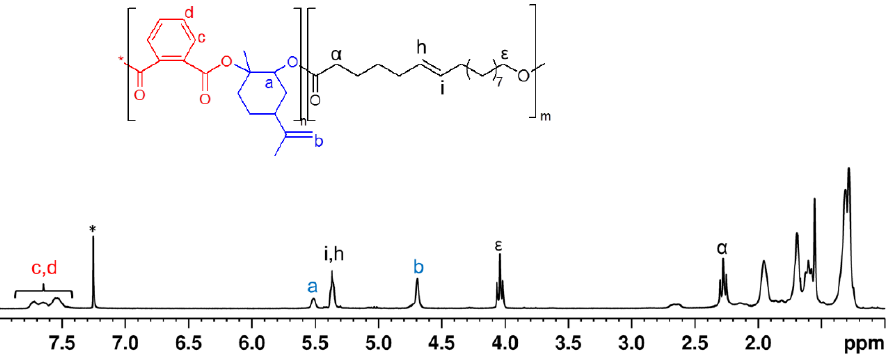
Figure 1. 1 HNMR (600 MHz, CDCl 3 , RT) of poly(limonene-phthalate)- block -poly(hexadecenlactone). The di-block structure of the copolymer was assessed by different experiments. As a